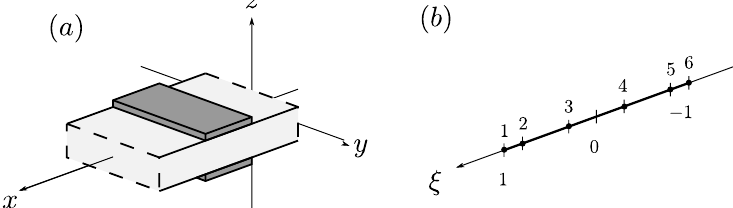
Figure 3. ( a ) A unit cell in the global coordinate system ( b ) A node distribution in element coordinate